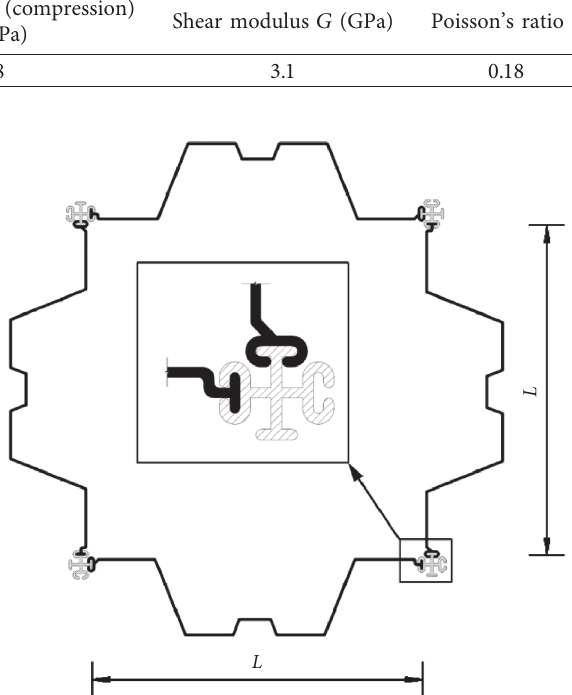
Figure 5: Configuration of the pile foundation for Test